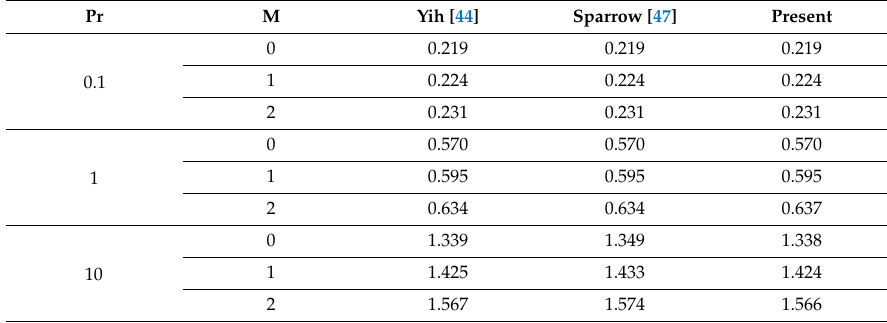
Table 3. Comparison of results of dimensionless heat transfer when Nb = Nt = 0, δ v = δ T = 0, Da → ∞ , R → ∞ , λ = Ω = 0, K = 1.